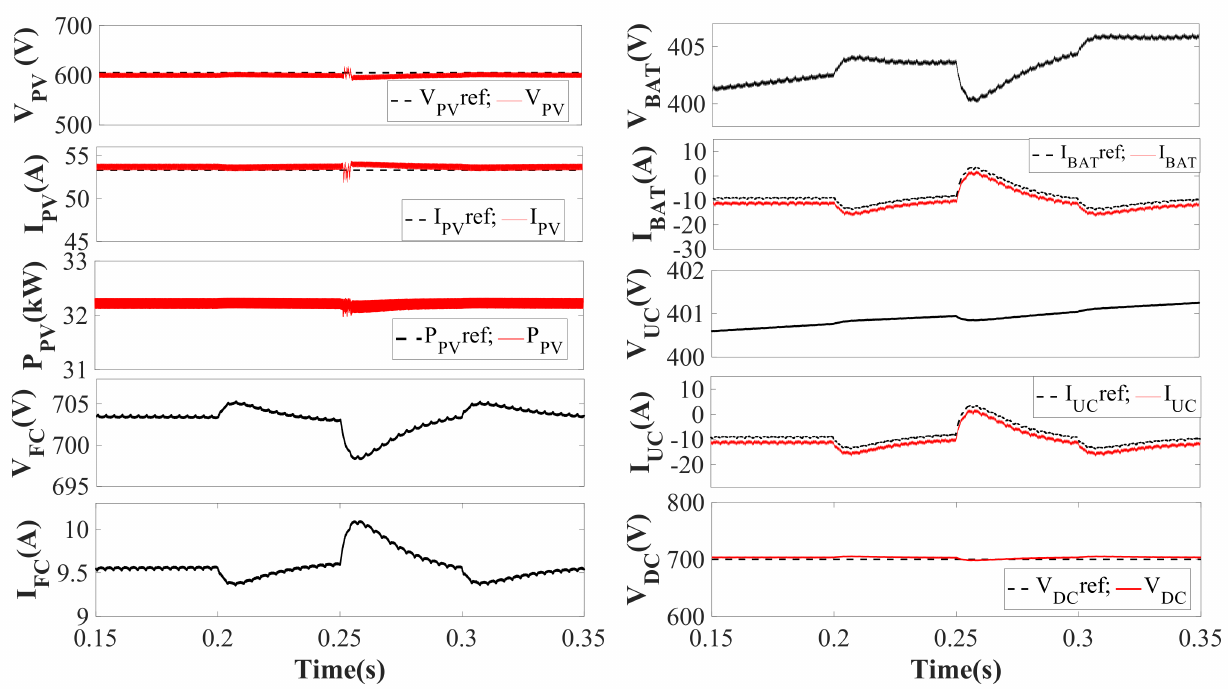
Figure 13. Dynamic performance during abnormal grid voltage mode of V PV , I PV , P PV ,V FC , I FC , V Bat , I Bat , V UC , I UC , and V DC